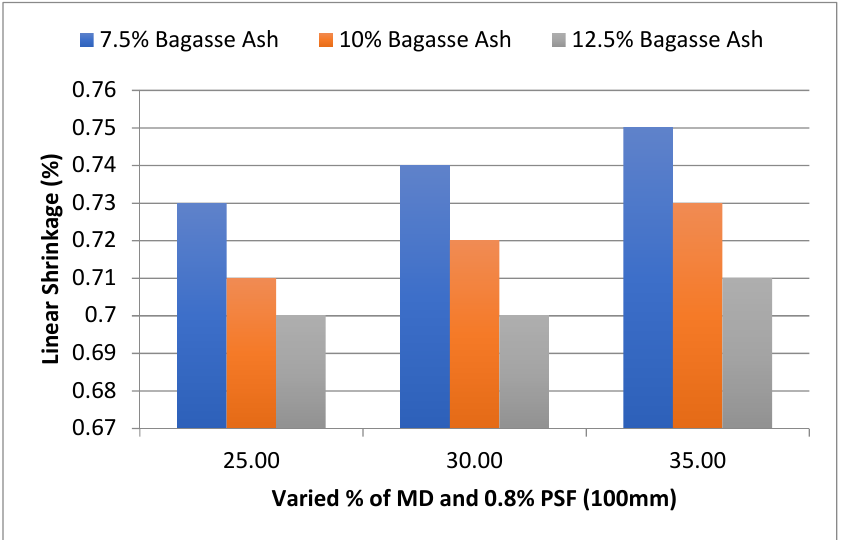
Figure 14. Effect of MD and BA on linear shrinkage of block reinforced with 0.8% PS fiber (100 mm).